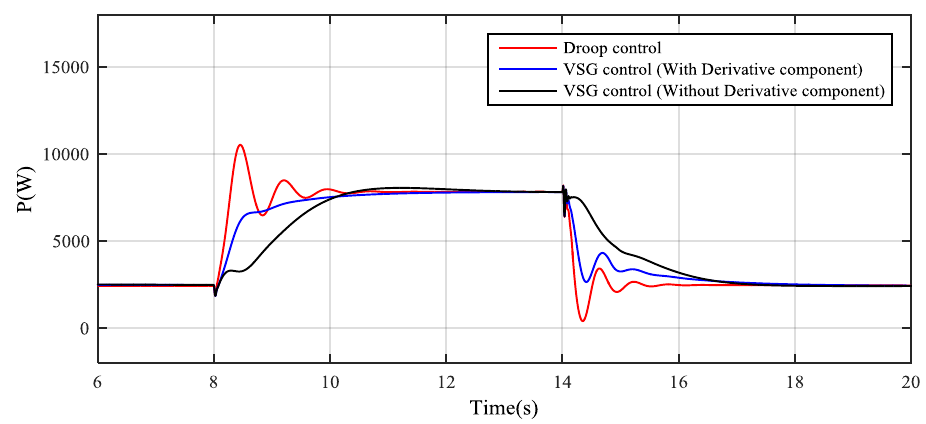
Figure 13. Active power of grid-feeding converter.